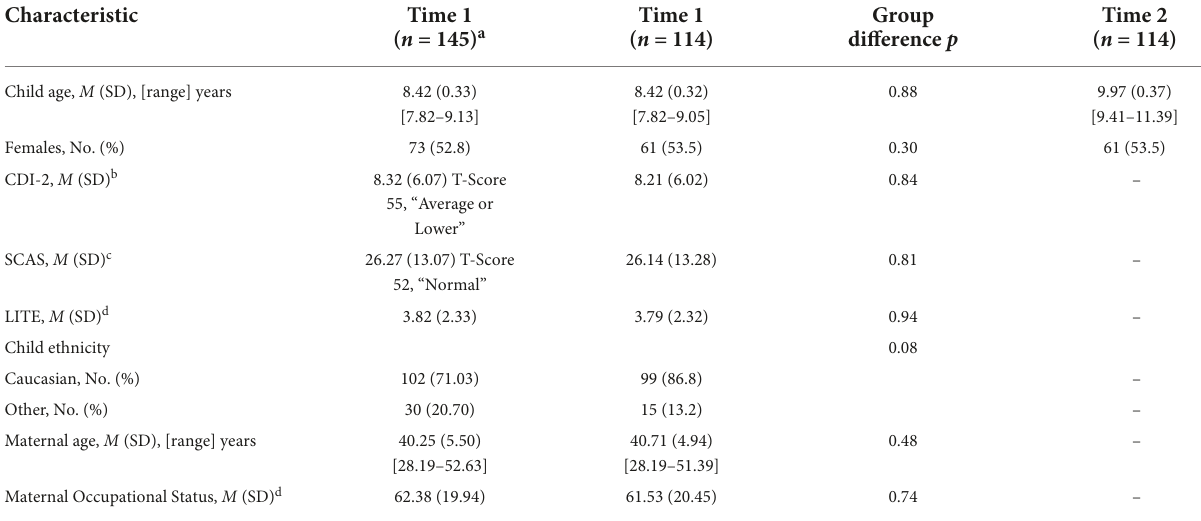
TABLE 1 Demographic and clinical participant information ( n =